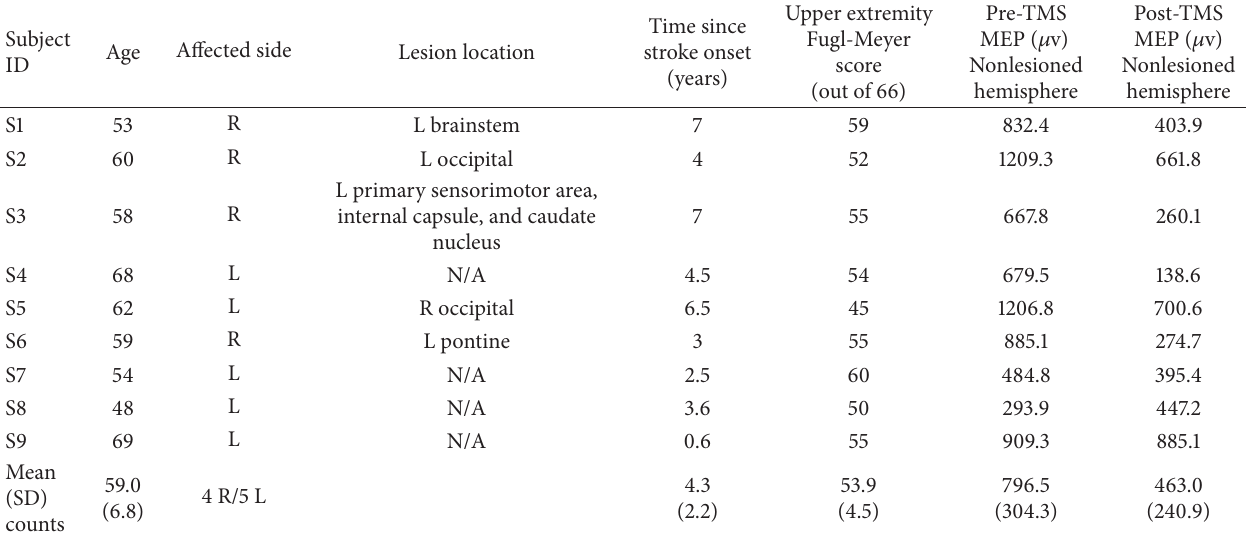
Table 1: Demographic information of 9 participants after